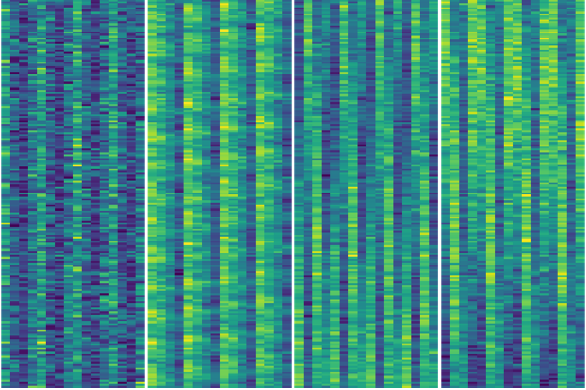
Figure 3. Visualization of original CSI.